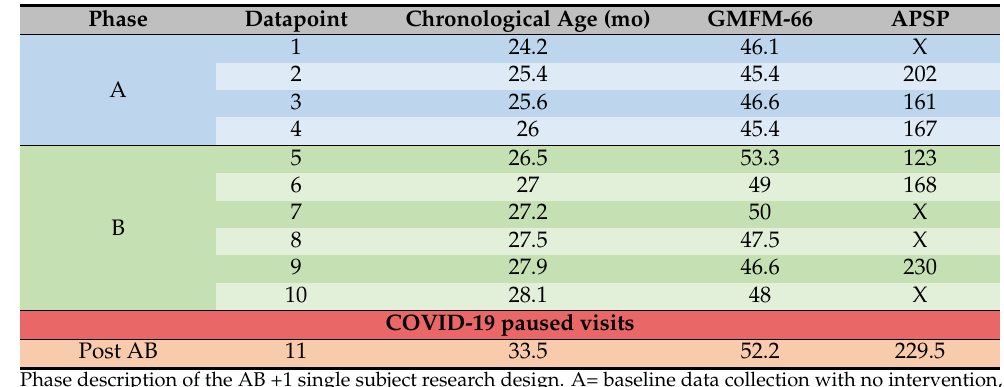
Table 1. Study Phases with Chronological Age and Data